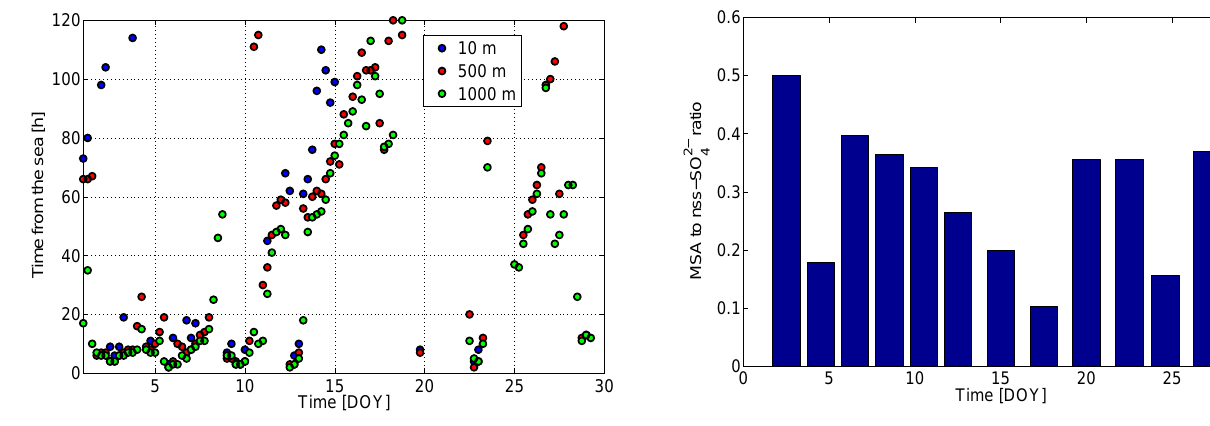
Fig. 4. Ratio of MSA [ngm − 3 ] to nss-sulphate [ngm − 3 ] in a size range of 0.045–20µm at Aboa, January 2007.